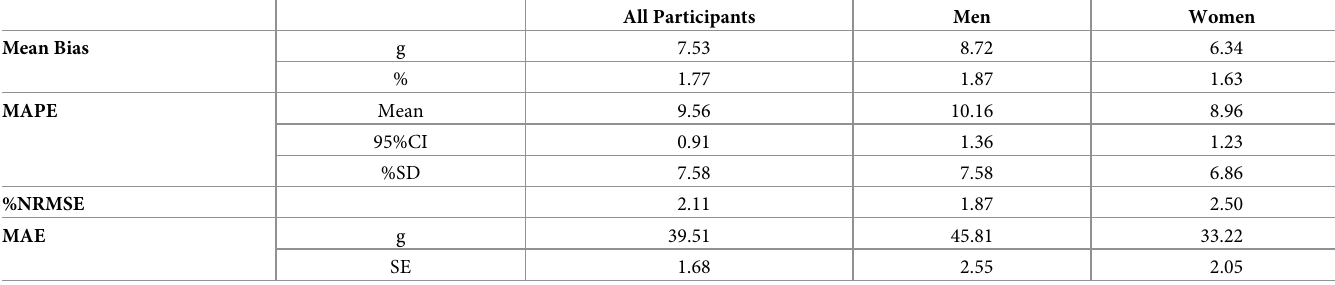
Table 1. Summary of statistical comparisons between DBM Samsung Gear S2 and the mass loss measurement standard method.